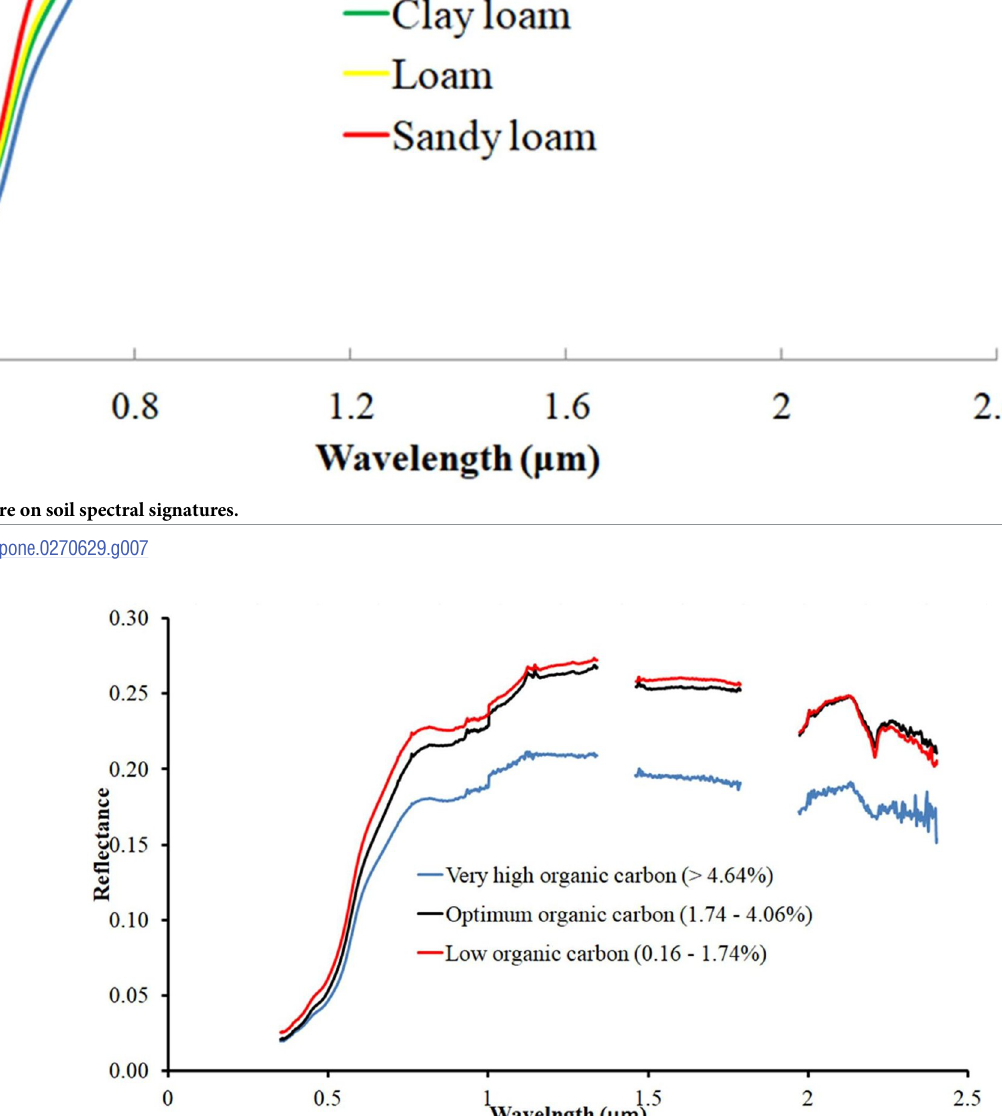
PLOS ONE | https://doi.org/10.1371/journal.pone.0270629 July 21, 2022 11 /